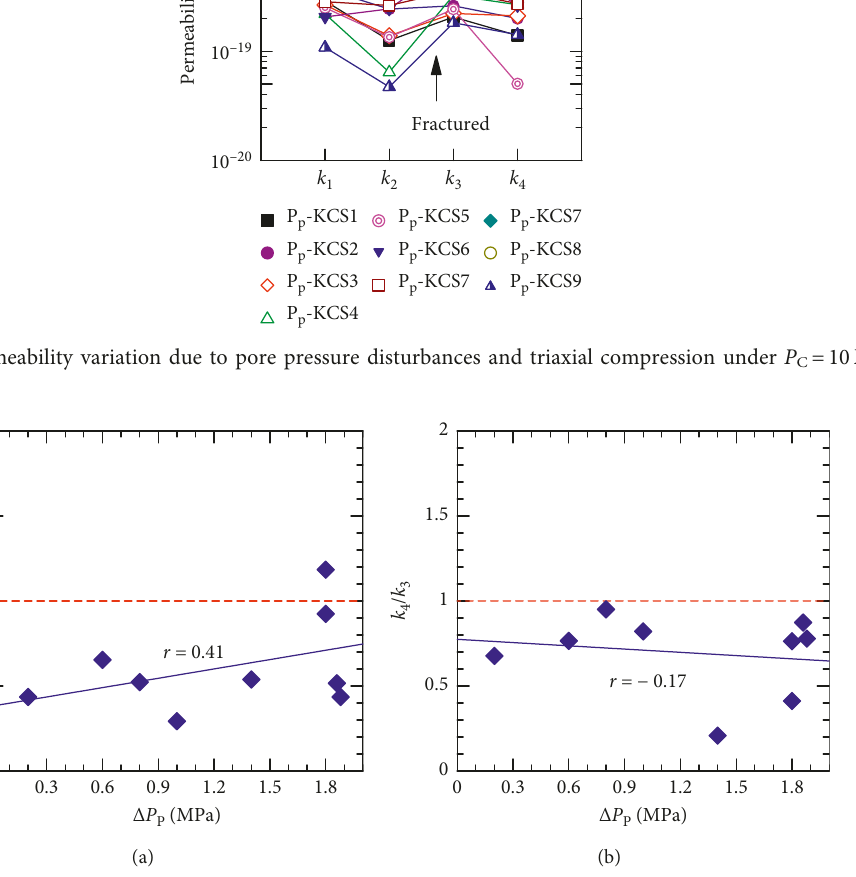
Figure 14: Effect of pore pressure disturbances on the permeability ratio of the Kushiro Cretaceous sandstone: (a) intact rocks and (b) fractured rocks.